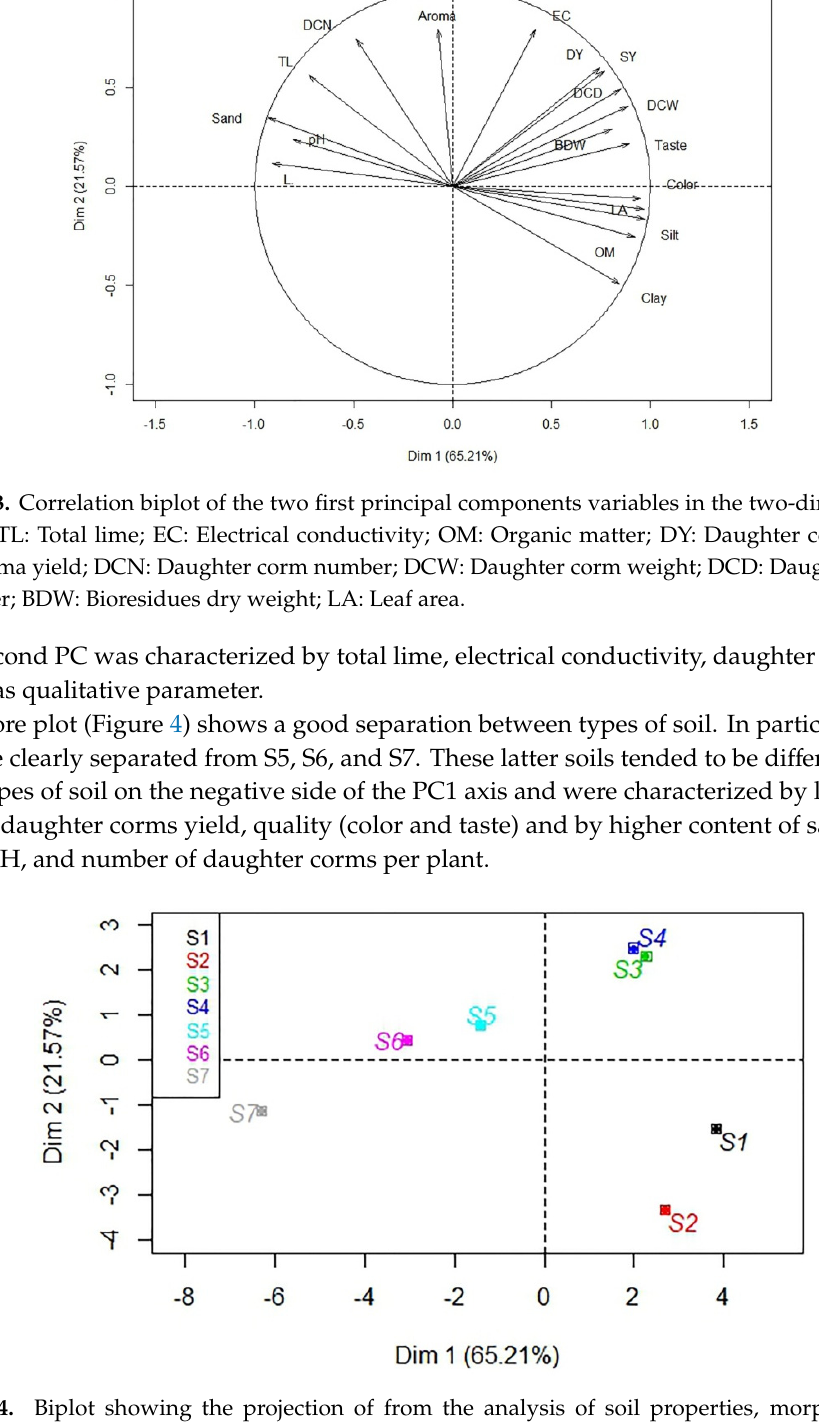
Figure 4. Biplot showing the projection of from the analysis of soil properties, morphological, quantitative and qualitative